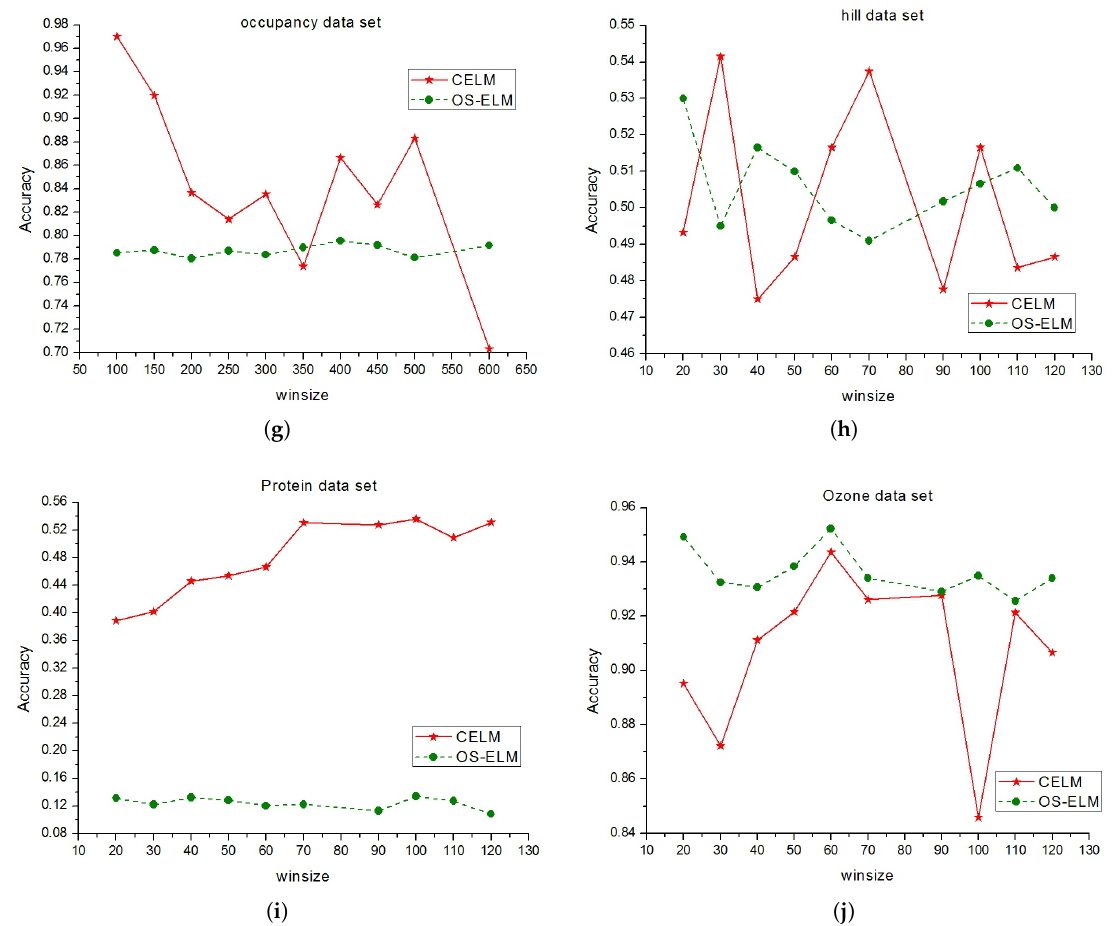
Figure 2. The test result of CELM and OS-ELM with different winsize